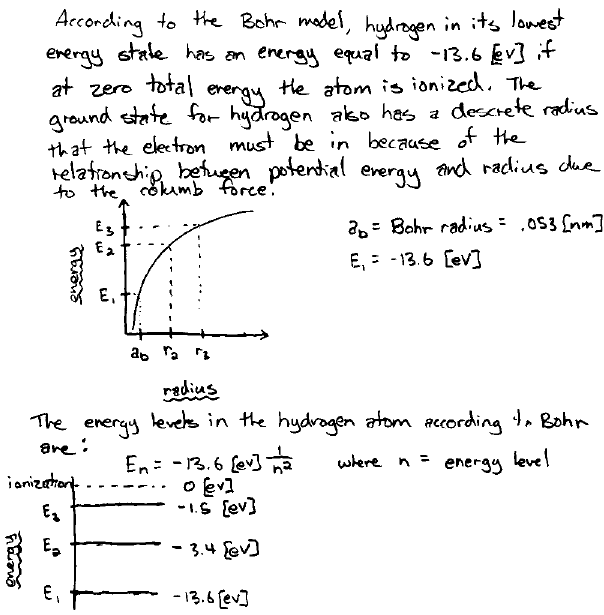
FIG. 8. Example of a student response coded as explicitly using the Bohr model only. This student began the description with “Ac- cording to the Bohr model,” and described the electron as being at a discrete radius, a characteristic of the Bohr